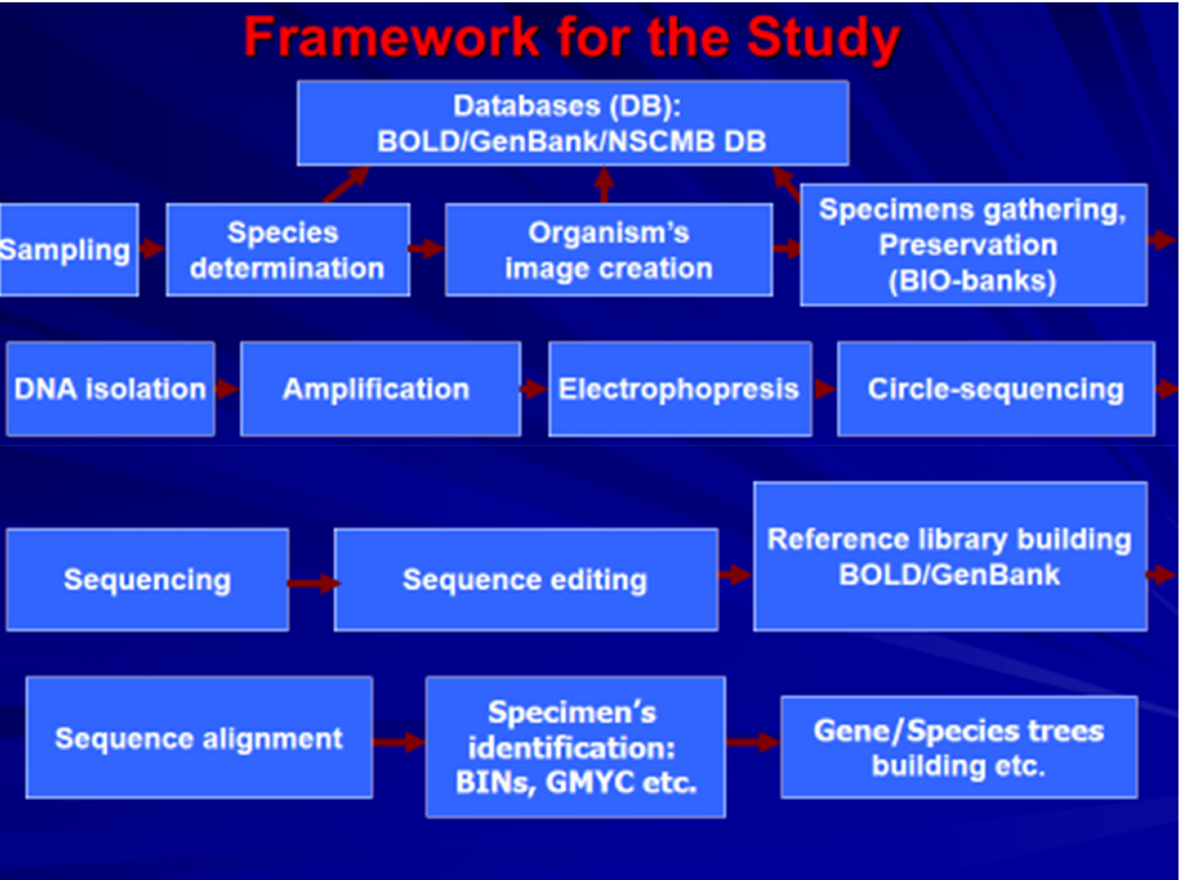
Figure 1. The scheme that illustrates the main steps and activities necessary to develop DNA barcoding and other associated fields of